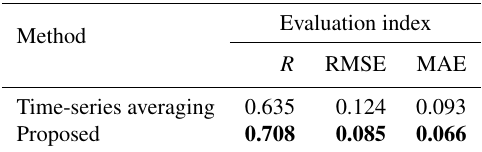
Table 3. Evaluation index ( R , RMSE, MAE) comparisons between the time-series averaging and proposed method. The better indexes are marked in